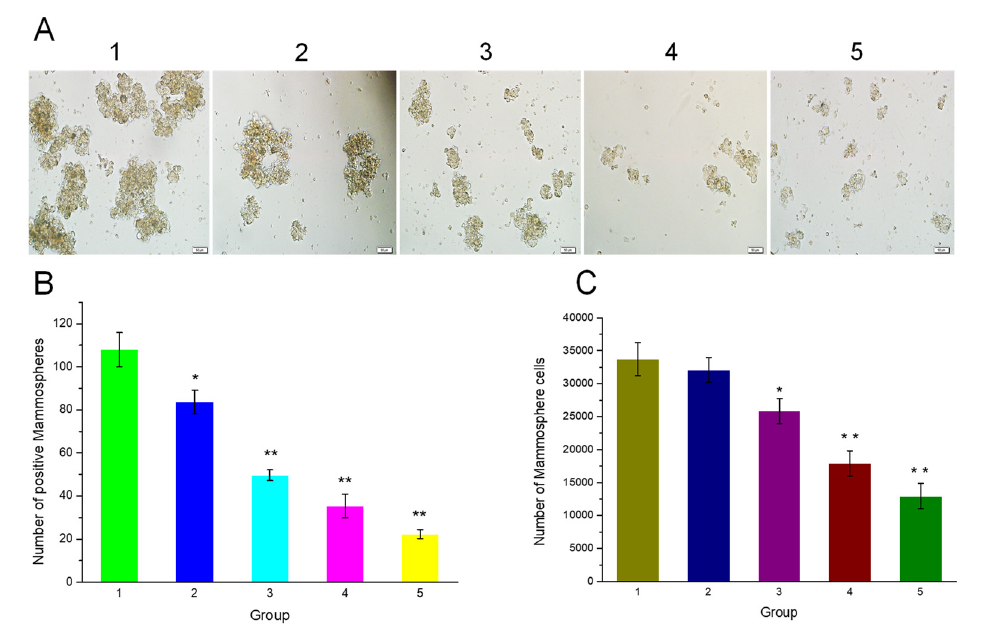
Figure 10. ( A ) The morphology of mammospheres after treatment with HA-capped AuNPs (with or without NIR laser) at different concentrations, scale bar = 50 μ m. The number of surviving mammospheres ( B ) or isolated mammosphere cells ( C ) after treatment with HA-capped AuNPs (with or without NIR laser) at different concentrations. The numbers represent the following: 1 for control group, 2 for 5 μ g/mL AuNPs group, 3 for 5 μ g/mL AuNPs + L group, 4 for 30 μ g/mL AuNPs group, 5 for 30 μ g/mL AuNPs + L group. * p < 0.05, ** p < 0.01 vs. control group.